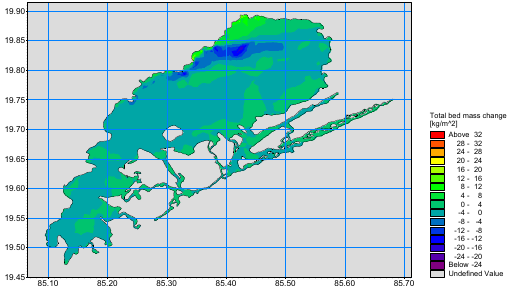
Figure 7g. Simulated spatial profile of Total bed